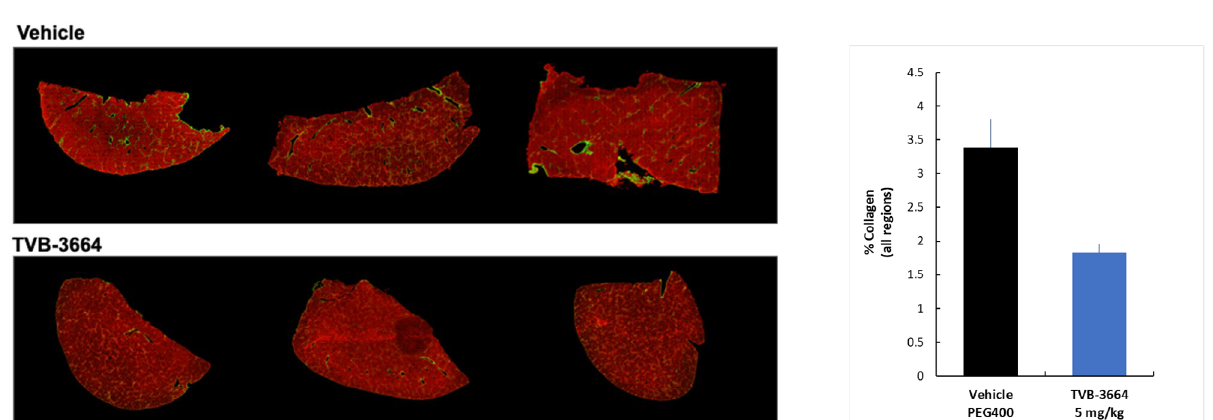
Figure 4. FASN inhibition reduces established fibrosis and hepatocellular carcinoma tumor formation in the FAT-NASH (CCl 4 ) Model. ( a ) Effect of FASNi on liver fibrosis by conventional pathology. Left: Photomicrograph of representative sirius red/fast green stained liver sections from vehicle or TVB-3664 treatment (5 mg/kg). Right: Quantification of fibrillar collagen using BioQuant software. *p < 0.0 vs vehicle, unpaired two tailed Mann–Whitney test. ( b ) Effect of FASNi on liver fibrosis by AI based digital pathology. Quantification of total collagen area using Second Harmonic Generation. Left: Representative images from vehicle and TVB-3664 treated. Collagen is represented in green. Right: Graph shows mean/SD of all animals. An expanded view of representative images is shown in Supplementary Fig. S2. ( c ) Effect of FASNi on the development of hepatocellular carcinoma. Number of liver tumors per animal at the end of treatment with vehicle or TVB-3664. ( d ) Effect of FASNi on appearance of livers at the end of treatment with vehicle or TVB- 3664. Representative images are